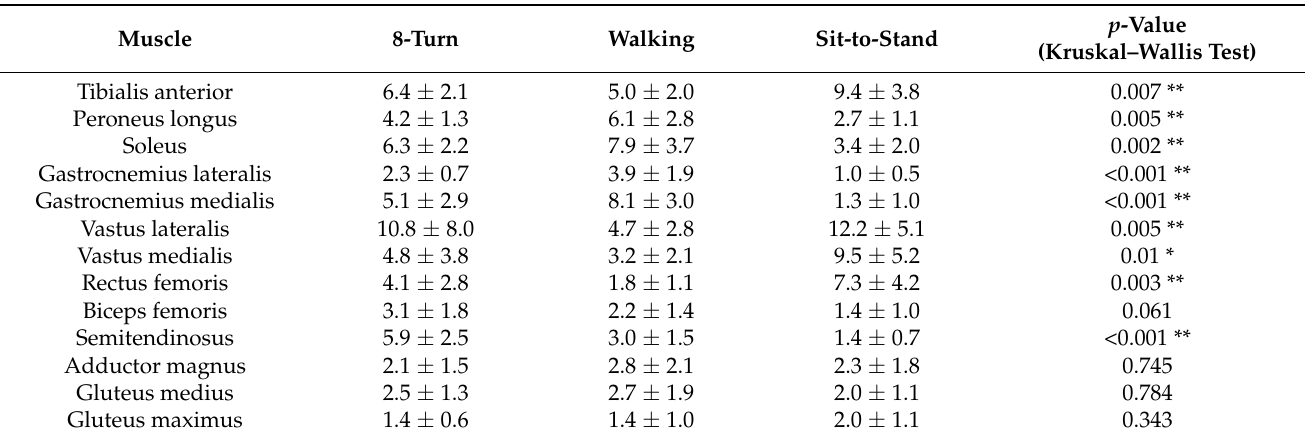
Table 2. Comparison of mean %MVIC in 8-turn LOCOBOT exercise with that of waking and sit-to- stand movement.